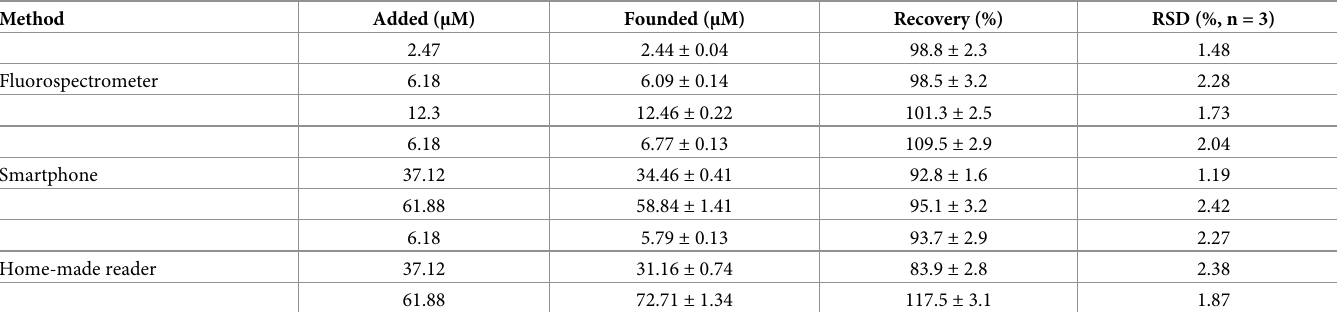
Table 2. Determination of SP in serum samples by three different detection systems.